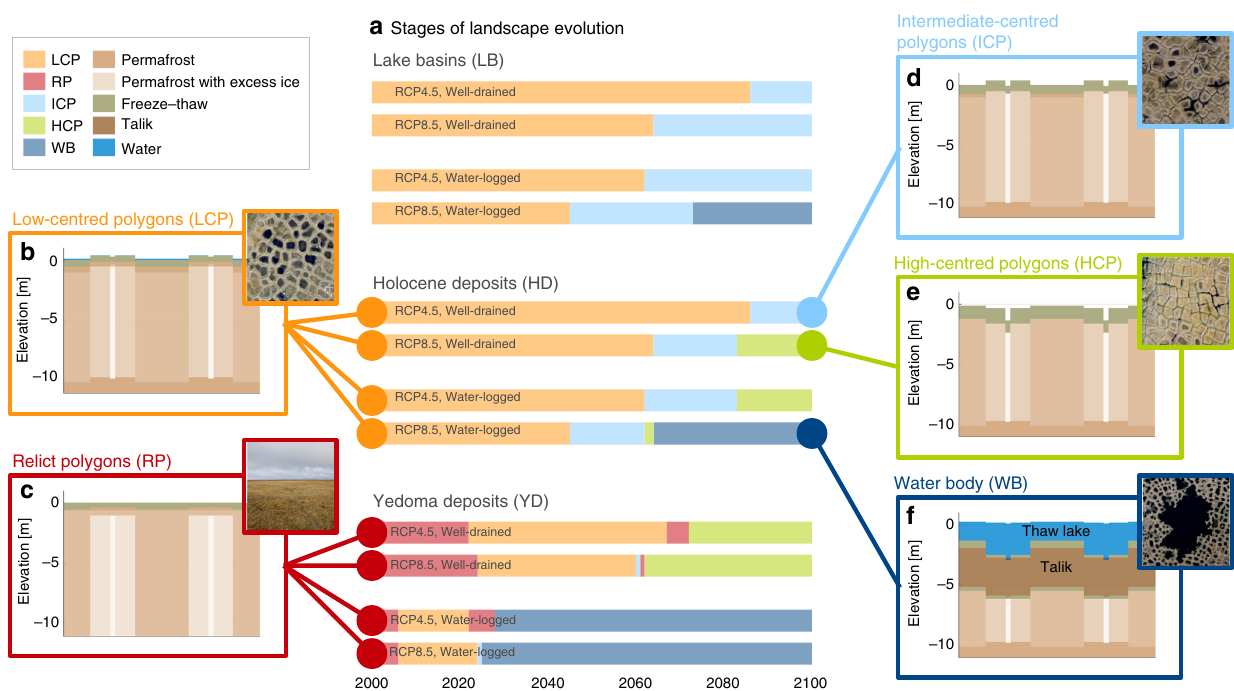
Fig. 2 Simulated evolution of ice-rich permafrost landscapes. Active low-centred polygons of drained lake basins and Holocene deposits (LCP, b ), as well as relict polygons of Yedoma deposits (RP, c ), initially host undegraded ice wedges. Melting of ice wedges under warming climatic conditions causes subsidence of the ground and a change in the microtopographic state of the landscape ( a ). Depending on the strength of the warming (RCP4.5 versus RCP8.5) and the hydrological conditions (well-drained versus water-logged), the landscapes evolve into intermediate-centred polygons (ICP, d ), high- centred polygons (HCP, e ) or water bodies (WB, f ) by the end of the twenty- fi rst century. Insets show aerial images of different states of ice-wedge terrain from study sites in northeast Siberia (Samoylov Island and Kurungnakh Island in the central Lena River delta). The initial and fi nal states of the landscapes as well as detailed trajectories of the soil surface altitudes are provided in Supplementary Figs. 3 and 5. Table 1 Surface and subsurface characteristics, areal coverage and number of soil samples of the different landscape types of the